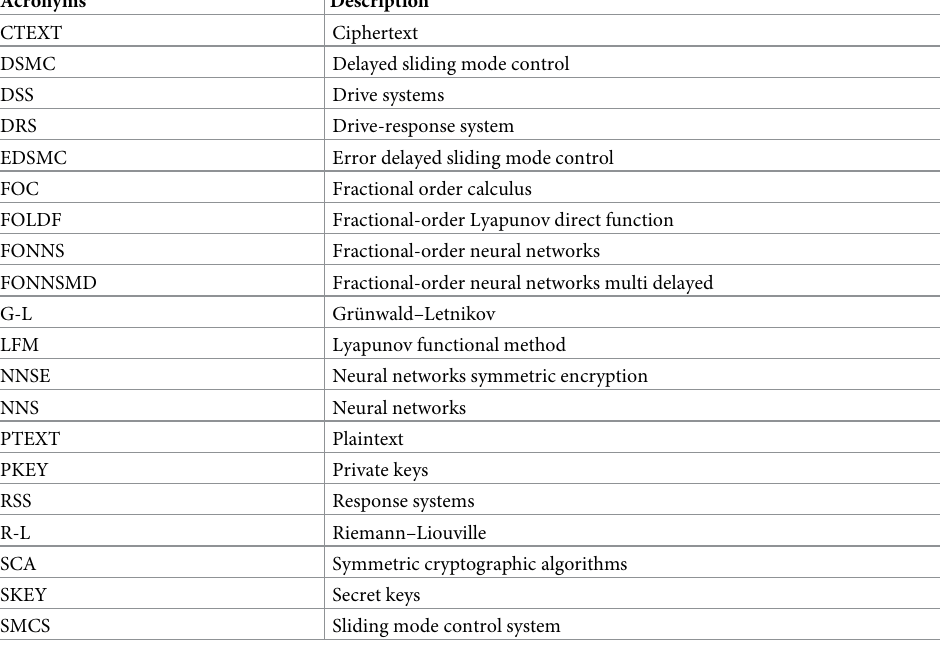
Table 1. Acronyms used in the